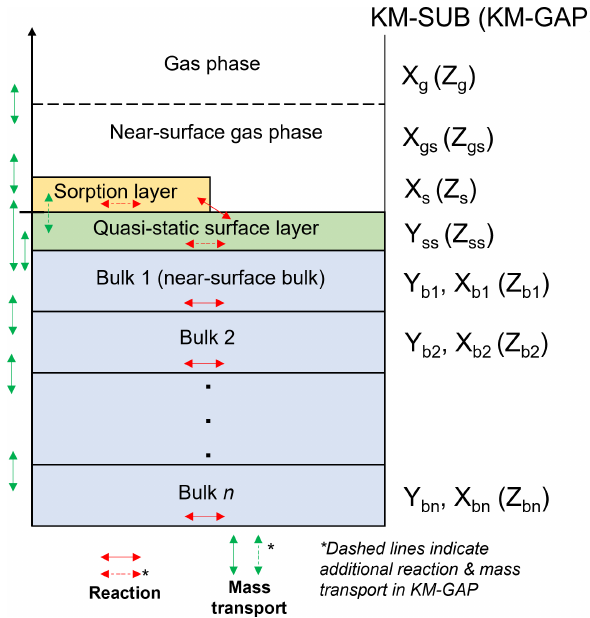
Figure 1. KM-SUB and KM-GAP model visualisation. A particle or film is split into sorption, quasi-static surface and n bulk layers. KM-SUB explicitly splits components into volatile ( X ) and non- volatile ( Y ), whereas KM-GAP treats all model components the same, and they are symbolised by Z by convention.